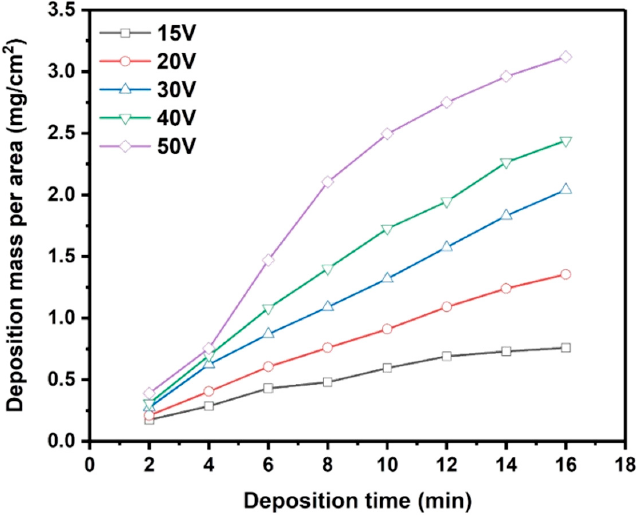
Figure 6. Deposition mass per unit area is a function of different times under different deposition voltages.